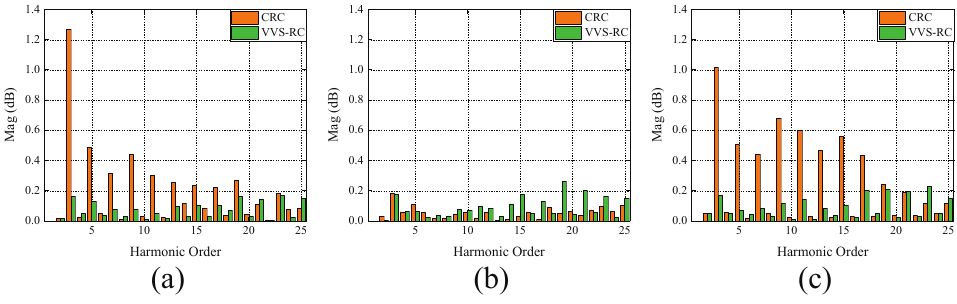
Figure 17. The FFT analysis of the grid current. ( a ) at 49 Hz. ( b ) at 50 Hz. ( c ) at 51